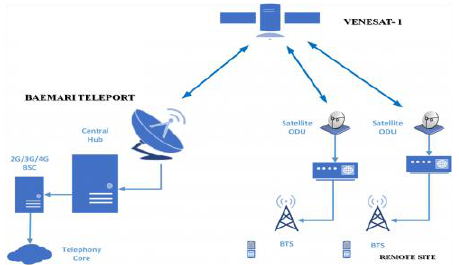
Figure 9. Technology solutions for disasters management Cellular Satellite Backhaul